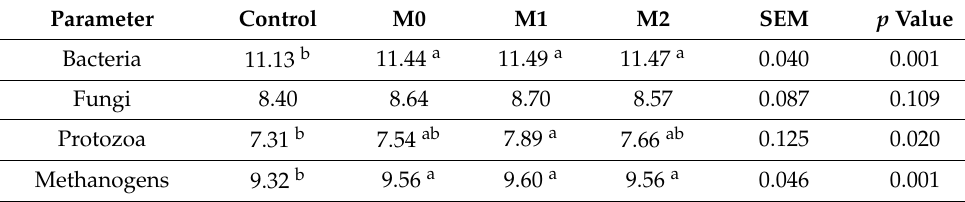
Table 6. Microbial populations (log10 copies per g of rumen